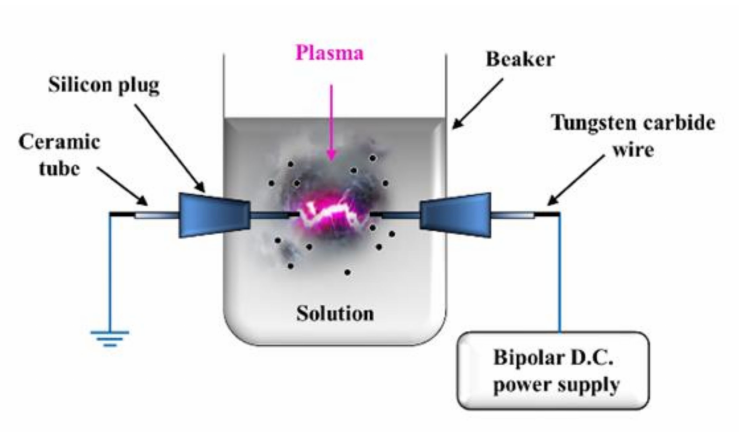
Figure 1. Schematic illustration of the experimental set up for plasma-in-liquid